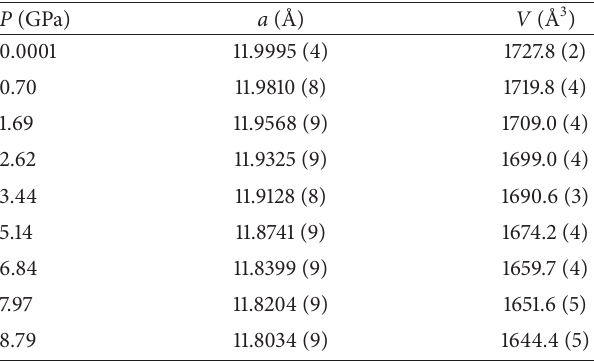
The pressure-volume data have been fitted to the third- order Birch-Murnaghan equation of state (III-BM-EoS) [34] to determine the elastic parameters Y (SiO ) . 3 2 4 3